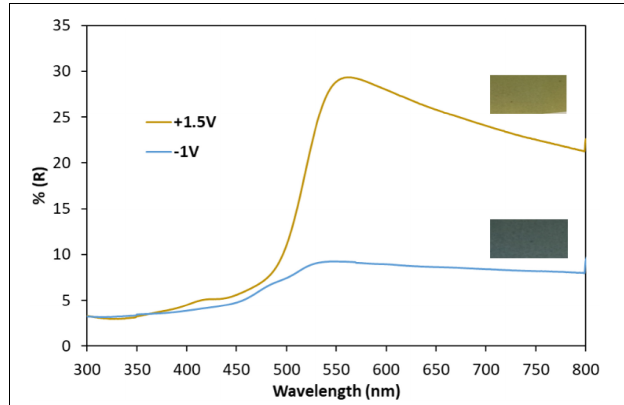
FIGURE 11 | Ex-situ reflectance spectra of the oxidized film (yellow-green) at +1.5 V and the reduced film (blue) at –1 V of the 3.7 µ m thick hybrid film of 90 wt%–10 wt% PEDOT:PSS-V 2 O 5 .